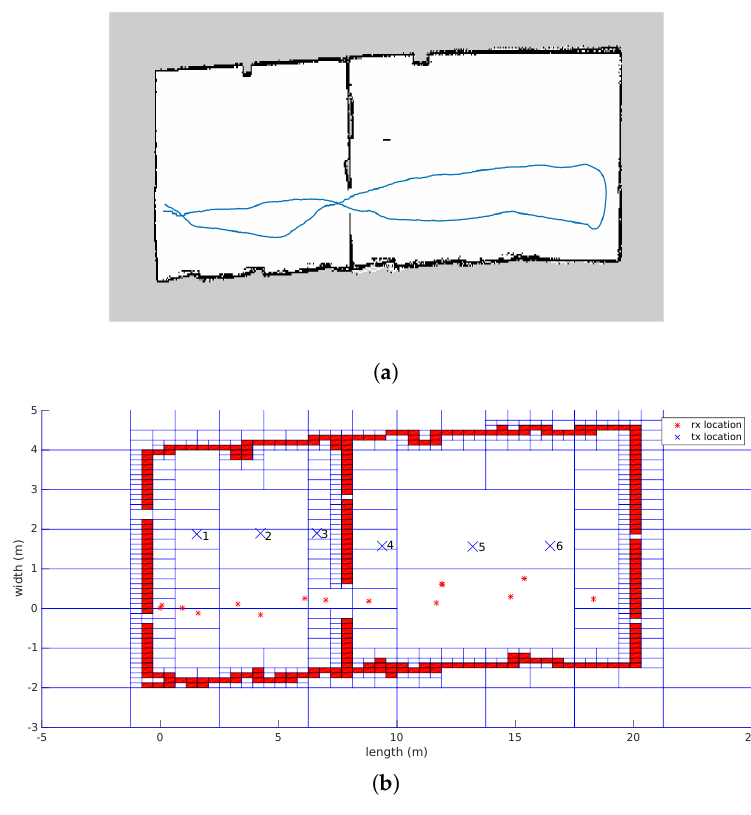
Figure 12. Office environment that was used to validate the propagation loss model. ( a ) SLAM results; ( b ) environment model with transmitter and receiver